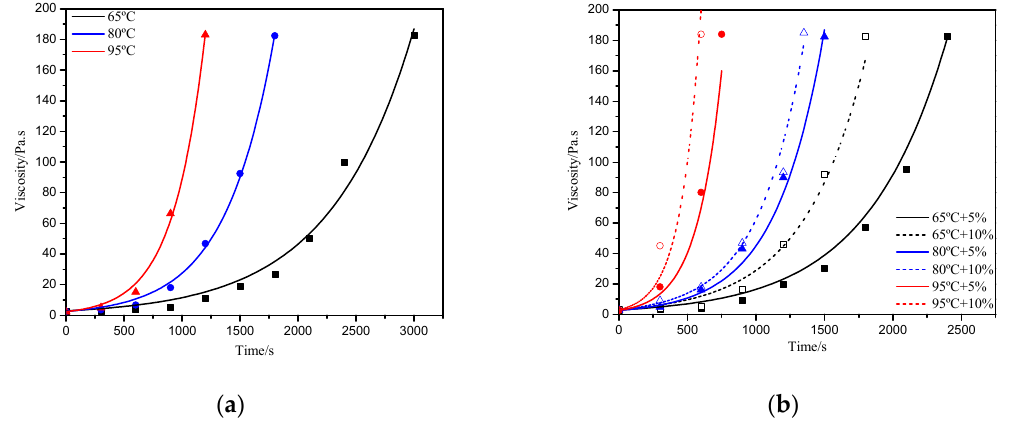
Figure 5. In situ viscosity measurement data of ( a ) pure silicone and ( b ) phosphor/silicone composites and their fitting results by the Arrhenius model.